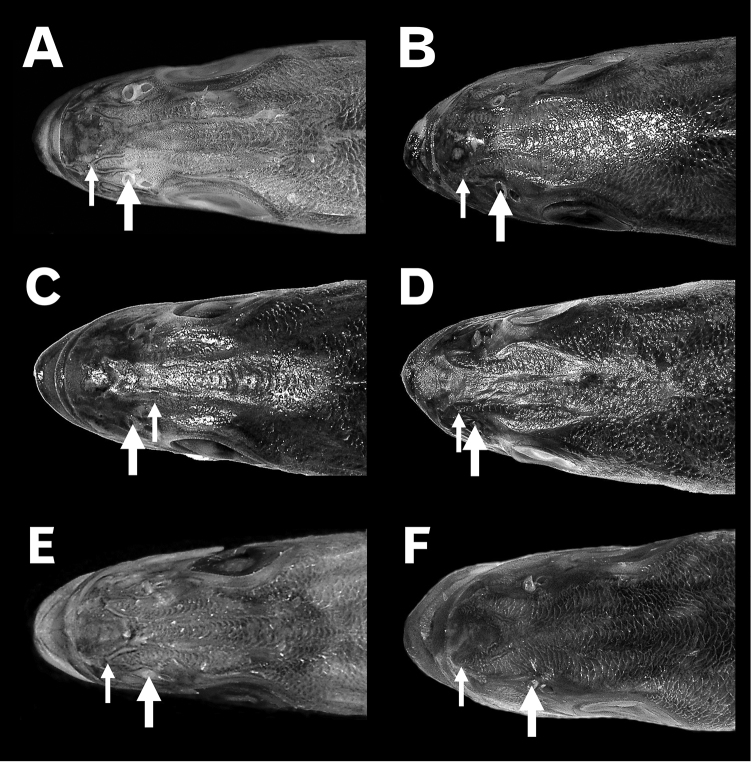
Squamation on dorsal head regions of Lateolabraxjaponicus (A, B), L.maculatus (C, D) and L.latus (E, F). Thick arrows indicate anterior nostrils, thin arrows indicate anterior edges of dorsocephalic scale rows. AKAUM–I. 93435 (137.0 mm SL) BBSKU 100803 (265.2 mm SL) C uncatalogued specimen (104.9 mm SL) DBSKU 100773 (254.2 mm SL) EKAUM–I. 39058 (114.2 mm SL) FKPM-NI 24255 (240.1 mm SL).